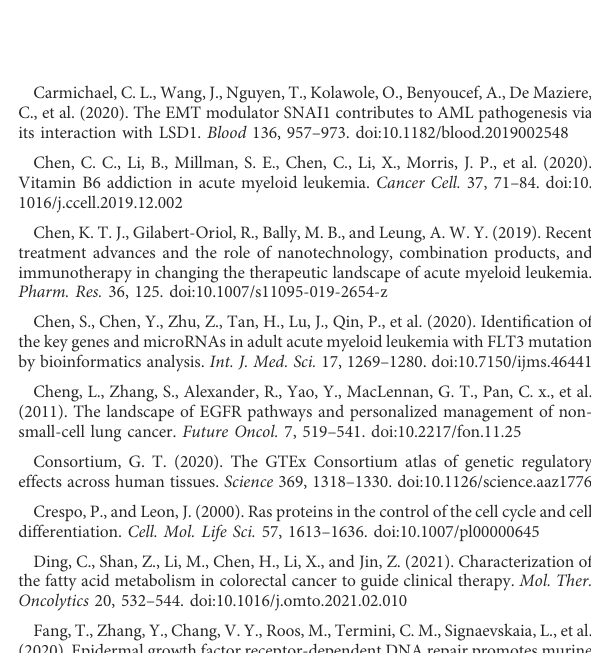
SUPPLEMENTARY FIGURE S2 (A) , Mutation frequency of SLC25A21 in leukaemia. SUPPLEMENTARY TABLE S1 Univariate and multivariate Cox regression analysis. SUPPLEMENTARY TABLE S2 GO enrichment and KEGG pathway analysis. SUPPLEMENTARY TABLE S3 Patient sample information. SUPPLEMENTARY TABLE S4 List of primer